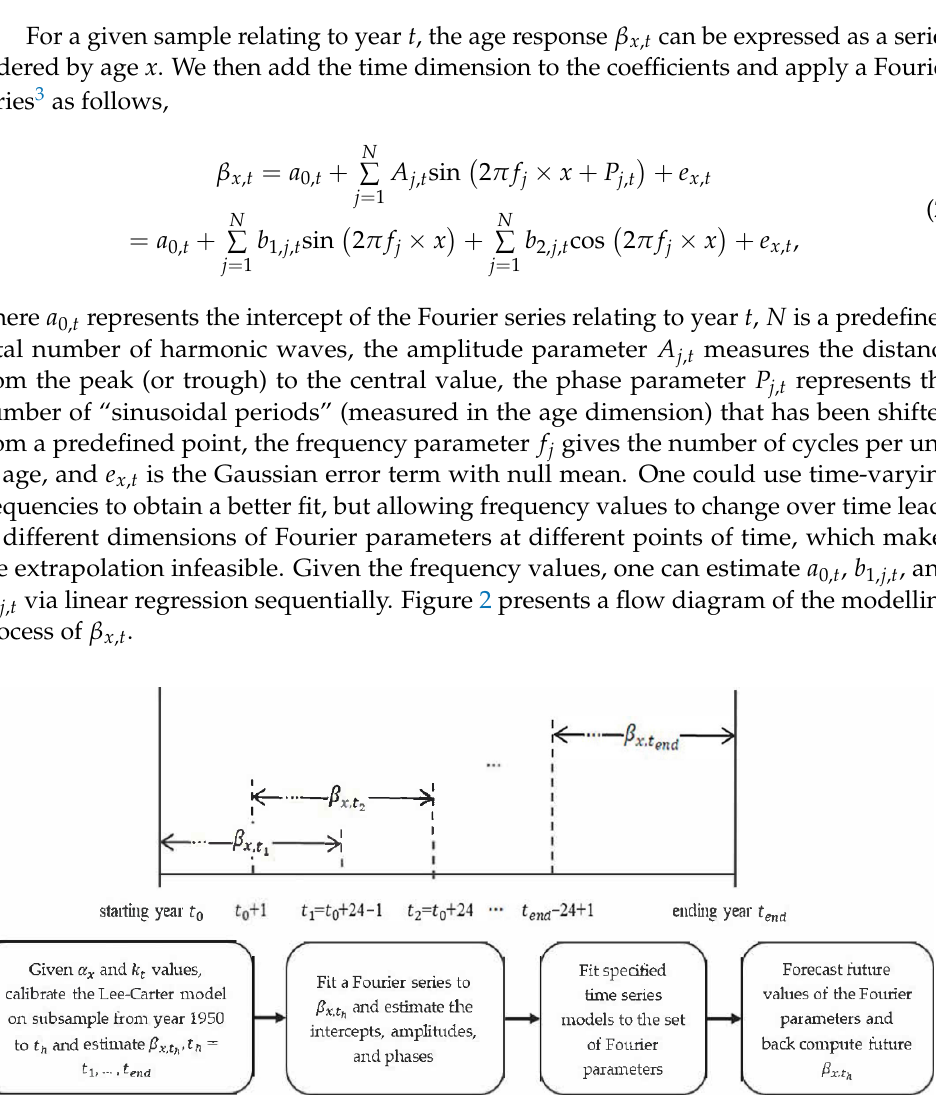
Figure 2. Modelling process of Fourier parameters for the age sensitivity factors.